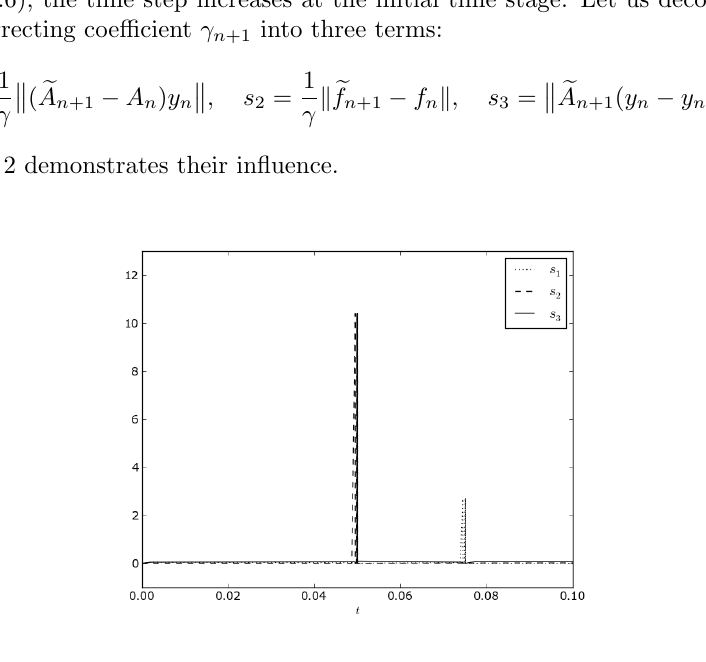
Figure 2. Terms of the correcting coefficient.